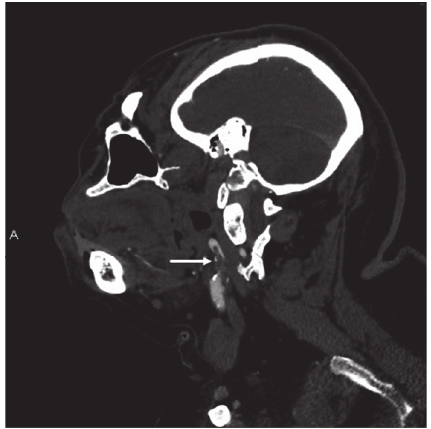
Figure 1: Coronal reformatted view from CT angiogram shows an intraluminal filling defect within the proximal left internal carotid arteryconsistentwiththrombus(whitearrow).Thereisalsoadjacent calcified atheromatous plaque (black asterisk). The internal carotid arteries are tortuous and deviate medially into the retropharyngeal space.